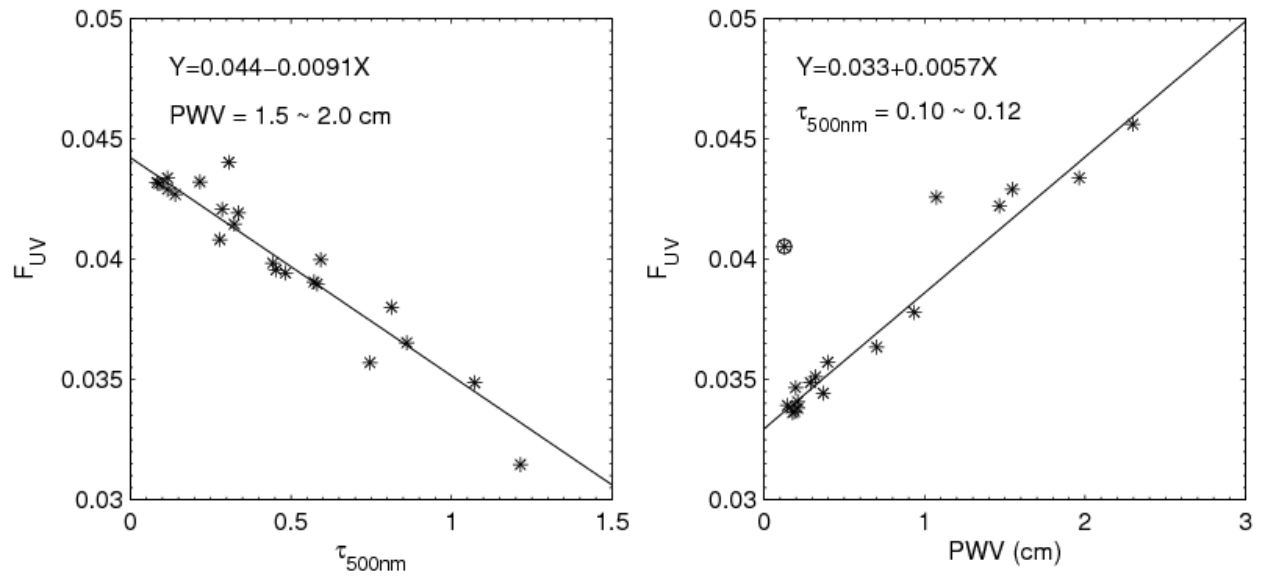
Fig. 1. The dependence of the fraction of UV to solar radiation ( F UV ) on aerosol optical depth at 500nm ( τ 500nm ) for daily precipitable water vapor content (PWV) of 1.5 ∼ 2.0cm (left) and on PWV for daily τ 500nm of 0.10 ∼ 0.12 (right). Table 1. Monthly mean fraction of UV to solar radiation and standard deviation (presented as percentage). Figure 1. The dependence of the fraction of UV to solar radiation (F ) on aerosol UV Mon optical depth at 500 nm ( τ ) for daily precipitable water vapor content (PWV) of 500nm 1.5 ~ 2.0 cm (left) and on PWV for daily τ of 0.10 ~ 0.12 (right). 500nm